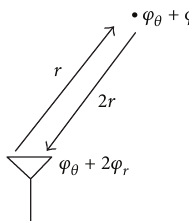
Figure 1: The different phases of radar signal caused by range.